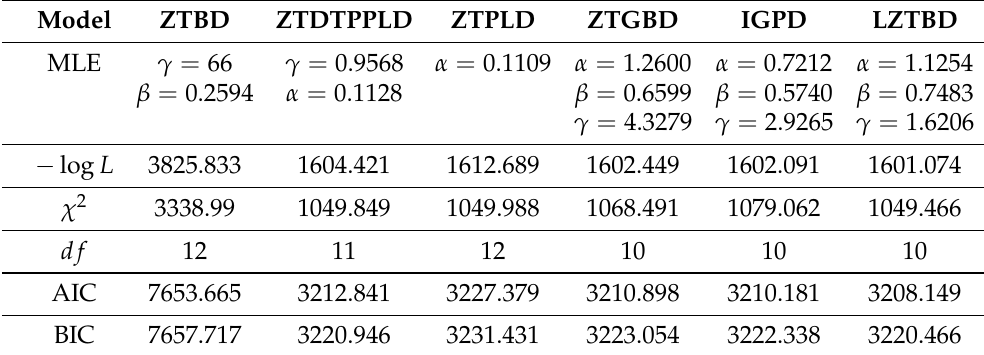
Table 12. Maximum likehood estimates (MLEs), model adequacy measures and χ 2 value for the Belgium data set.